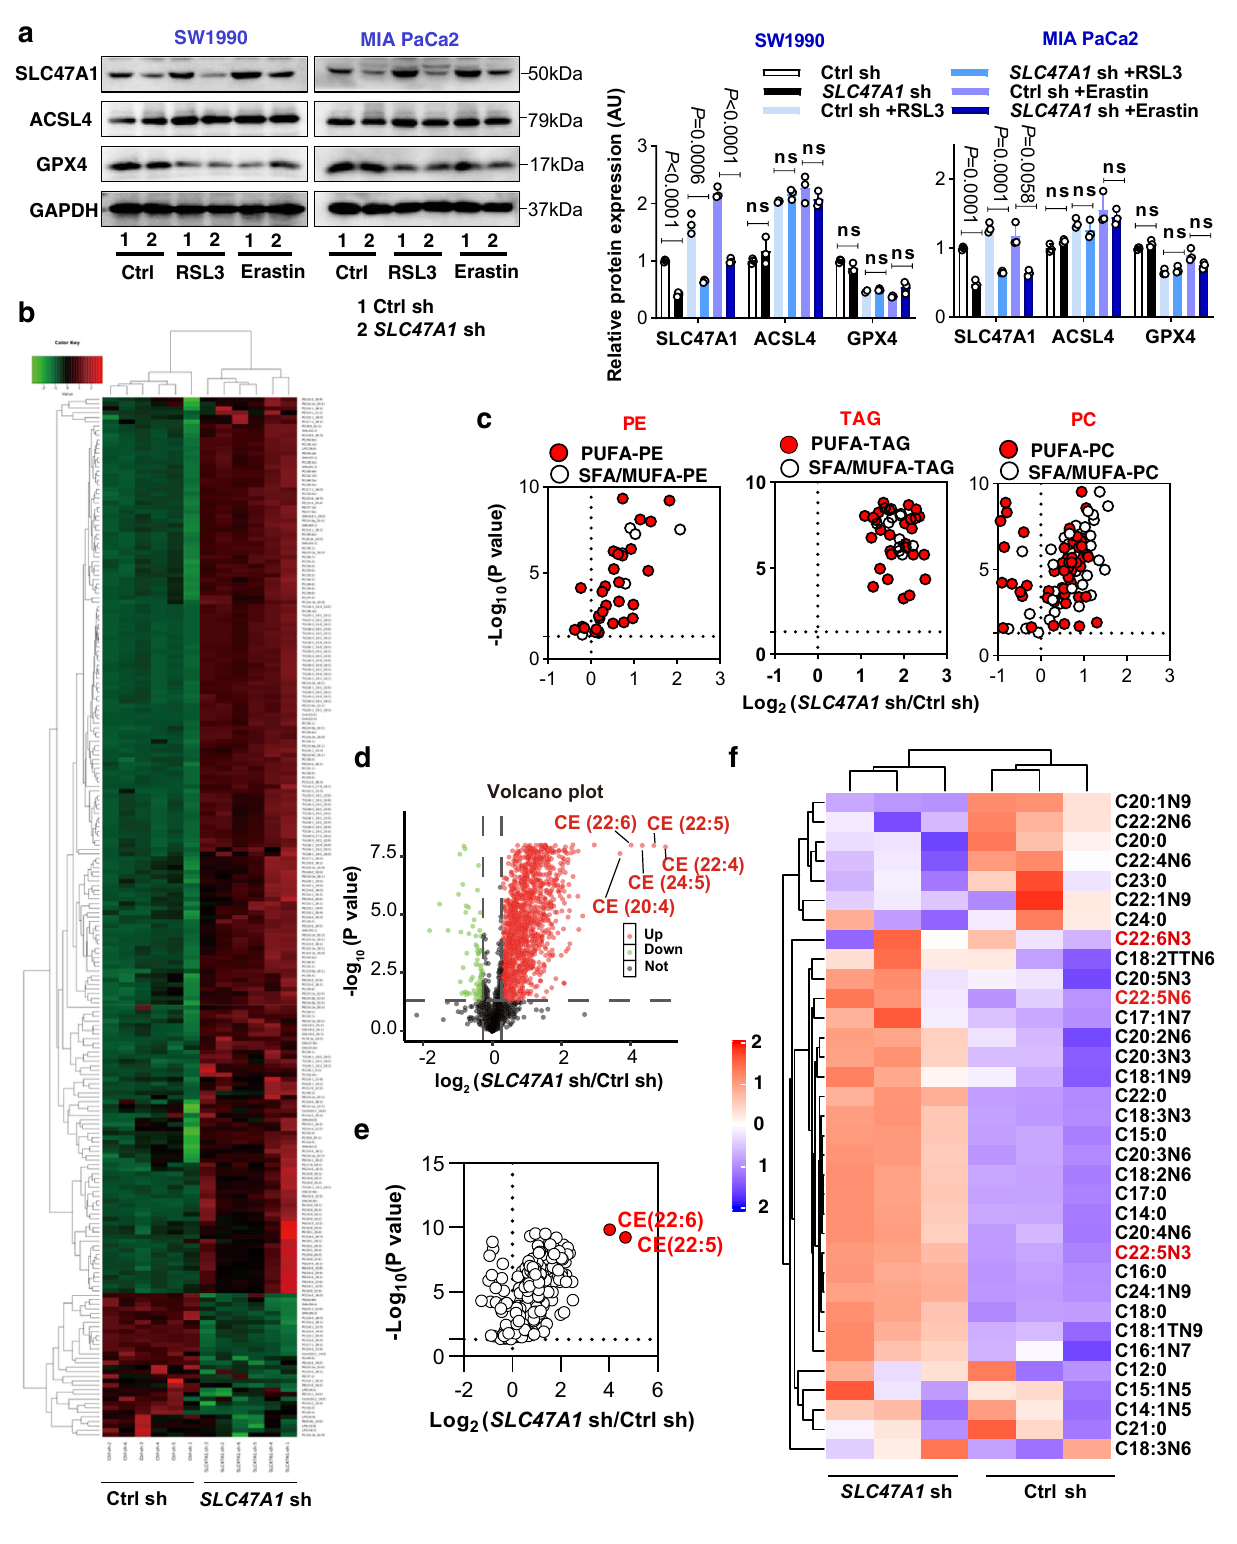
PPARA -knockdown SW1990 and MIA PaCa2 cells were sensitive to RSL3- or erastin-induced growth inhibition and cell death (Fig. 6d, e and Supplementary Fig. S6a). Ferrostatin-1 fully blocked RSL3- or erastin-induced cell death in PPARA -knockdown cells (Supplementary Fig. S6a). Lipid peroxidation analysis further con fi rmed the hypothesis that PPARA acts as a negative regulator of ferroptosis (Supplementary Fig. S6b). Consistent with experimental conclusions using PPARA